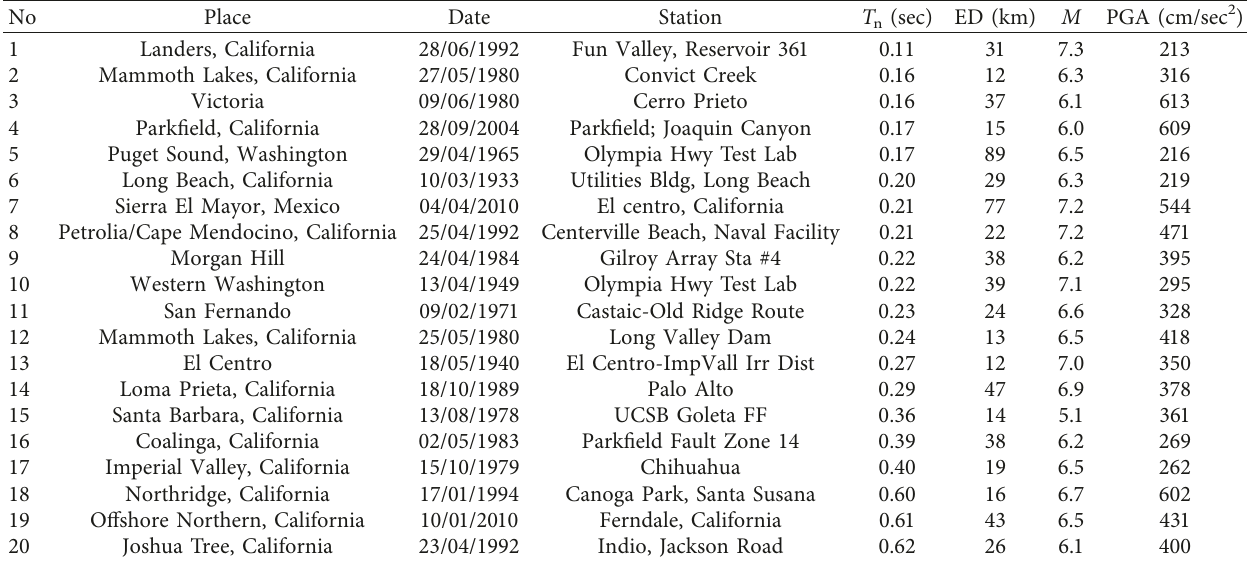
Table 2: Earthquake records, N-S